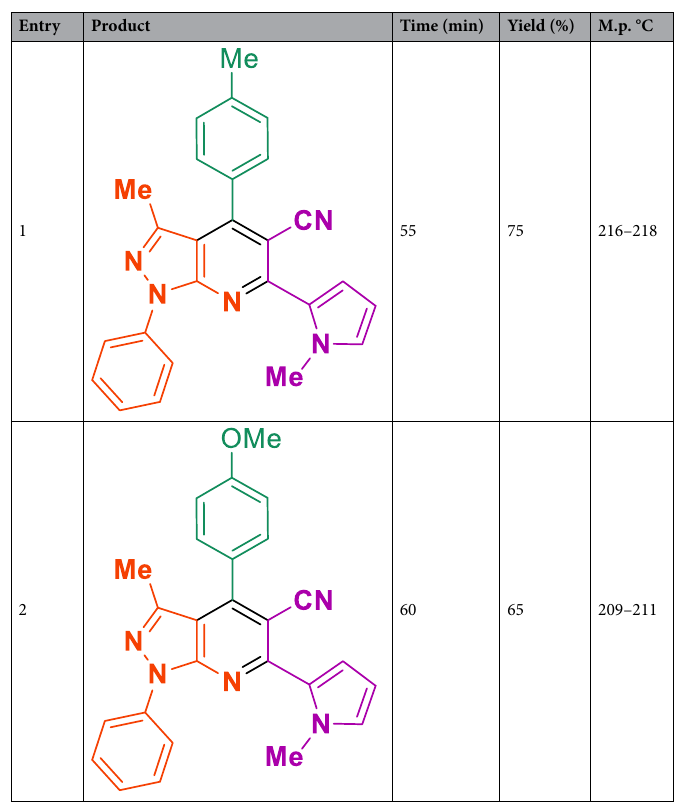
Table 5. Large scale synthesis of ( N -methyl-pyrrol)-pyrazolo[3,4- b